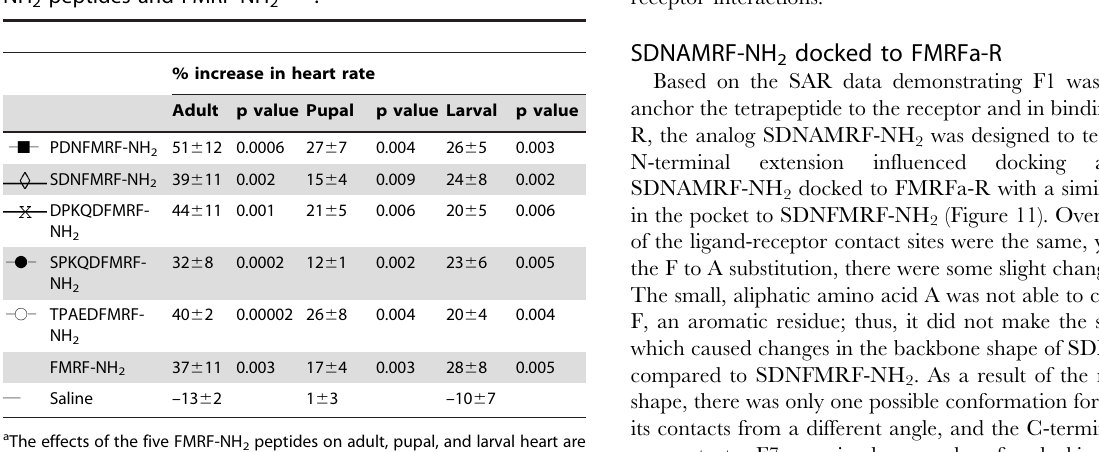
Table 12. Cardioexcitatory effects of D. melanogaster FMRF- NH 2 peptides and FMRF-NH 2 a, b .